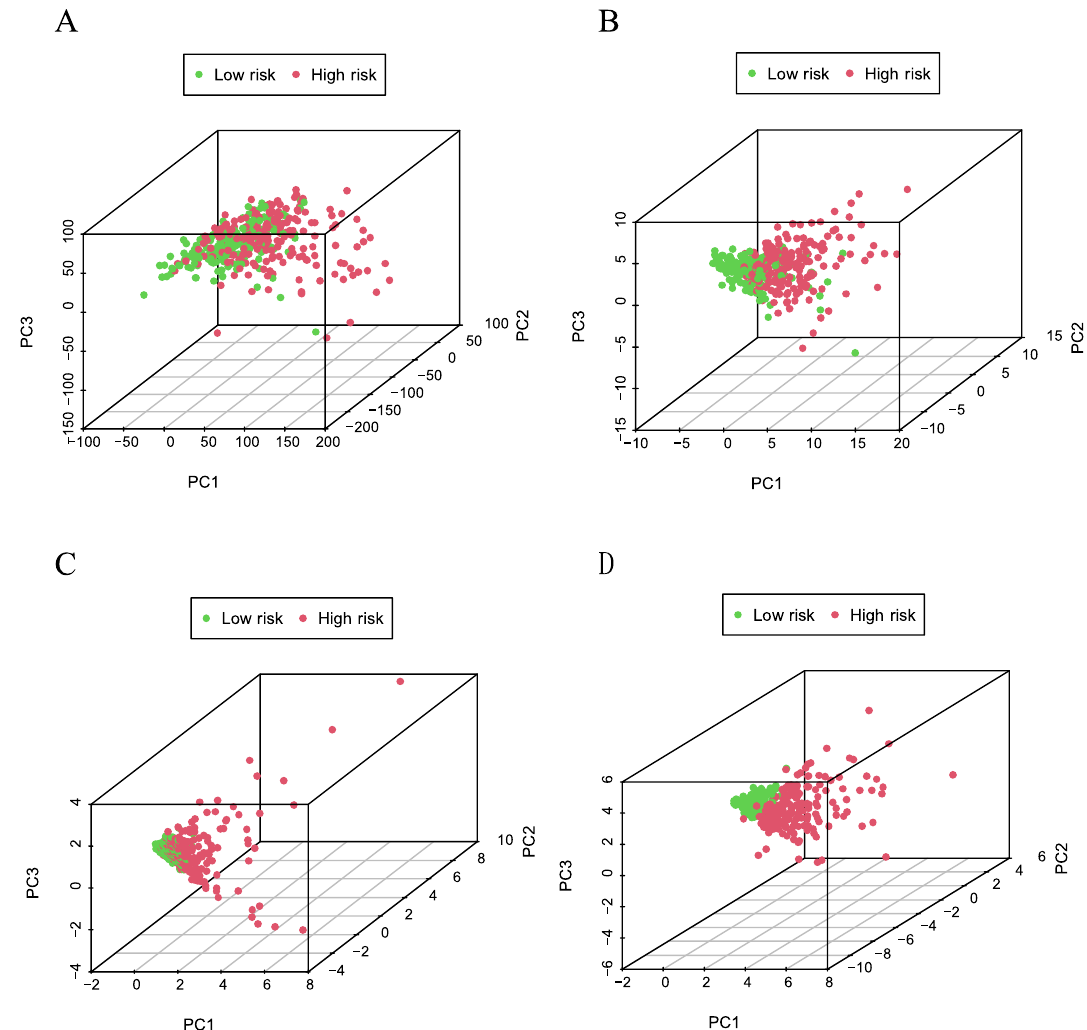
Figure 6. Principal component analysis between the high and low-risk groups in TCGA entire set. ( A ) entire gene expression profiles, ( B ) ferroptosis-related genes, ( C ) ferroptosis-related lncRNAs, ( D ) prognostic signature based on ferroptosis-related